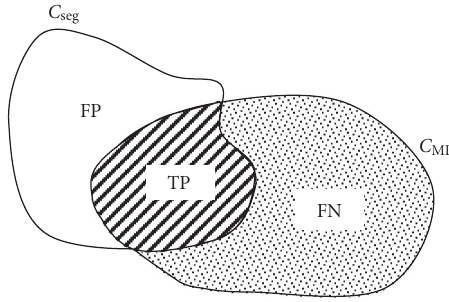
Figure 5: Quantitative measures of segmentation accuracy with volume fraction overlap and di ff